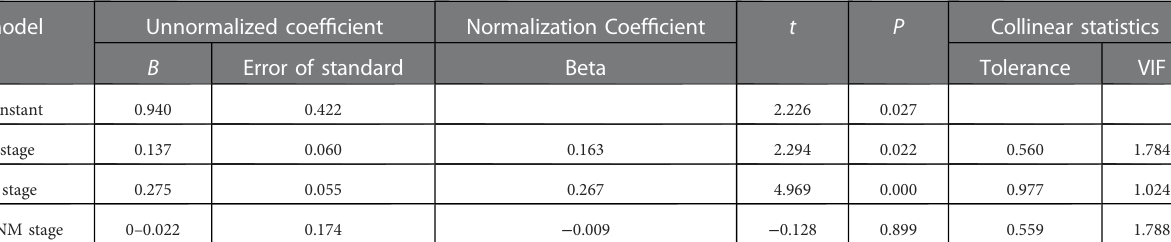
TABLE 2 Collinear analysis of T, N and TNM stage.